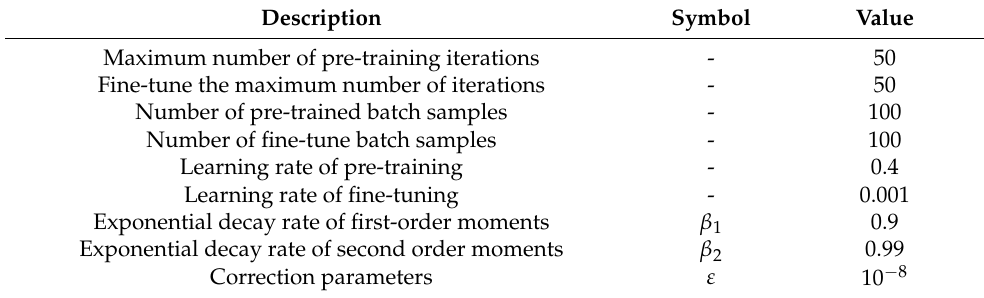
Table 3. ADBN network